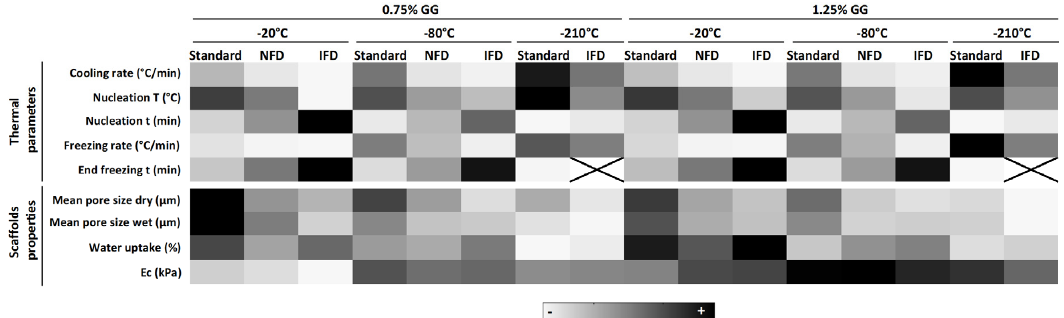
Figure 6. Heat map showing the relative effect of the freezing devices and temperatures, and polymer concentration on the different thermal parameters and scaffolds’ properties. T = temperature, t = time.